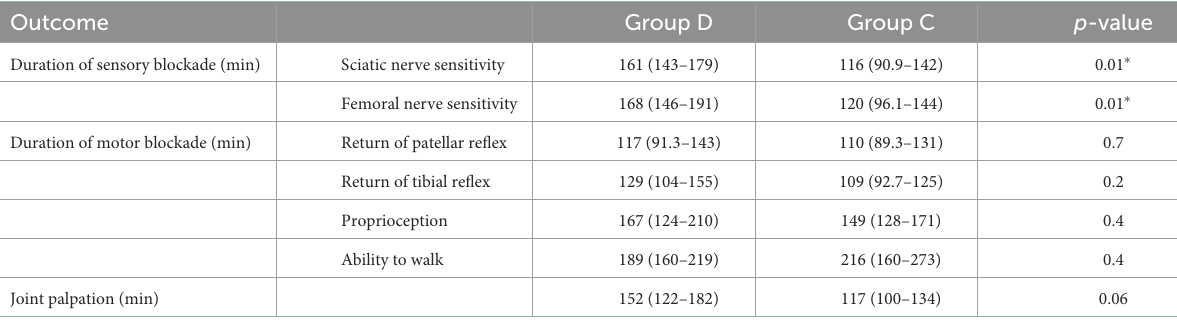
TABLE 4 Durations of sensory and motor blockades.